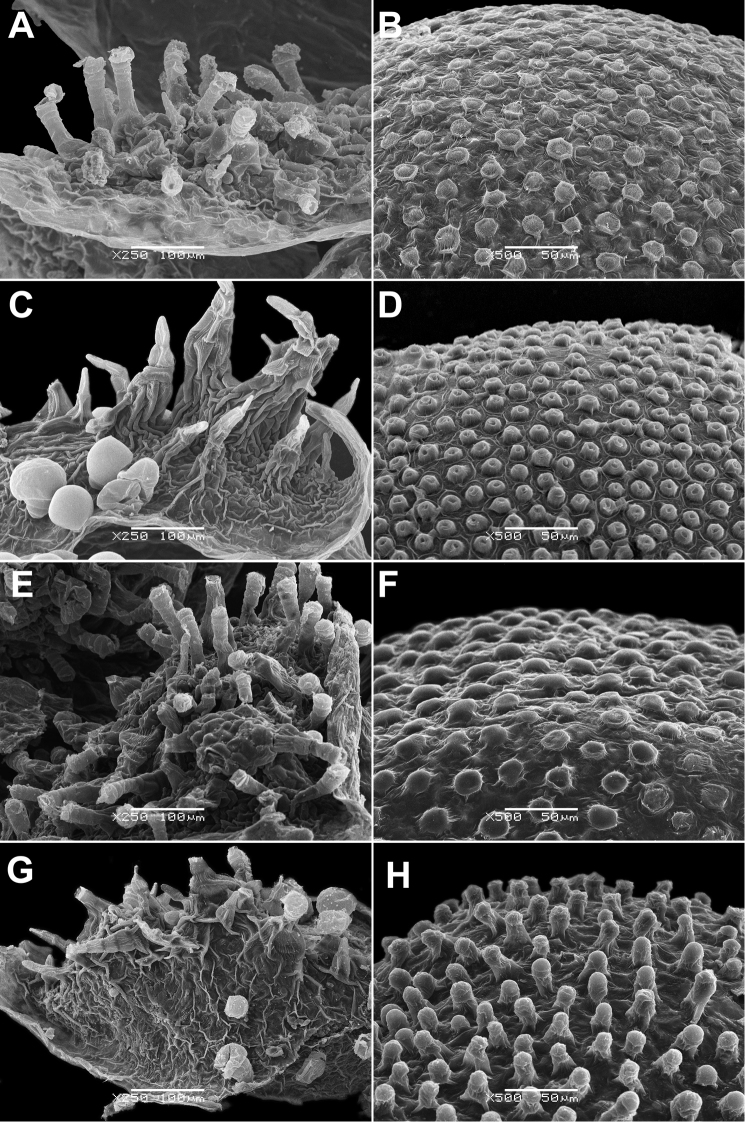
SEM micrographs: A perianth of D.botrysB pericarp of D.botrysC perianth of D.geoffreyiD pericarp of D.geoffreyiE perianth of D.neglectaF pericarp of D.neglectaG perianth of D.nepalensisH pericarp of D.nepalensis. Magnification: 250× (A, C, E, G), 500× (B, D, F, H).